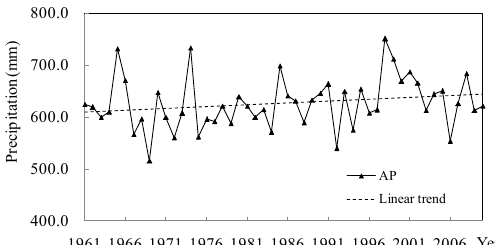
Fig. 2 Changes of AP during 1961–2010 in the Jinsha River basin.